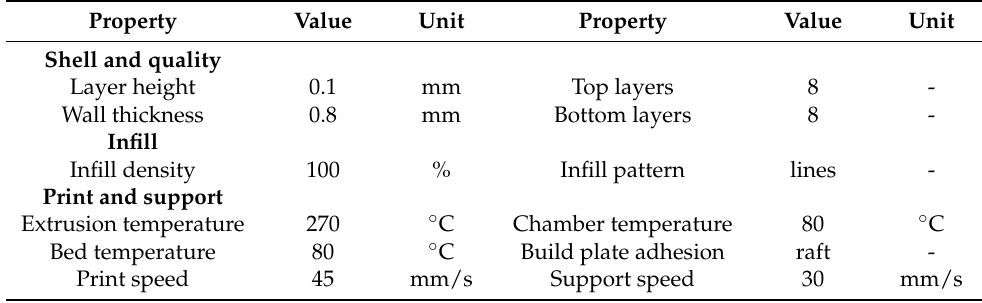
Table 2. Process parameters adopted for the FFF specimen fabrication.